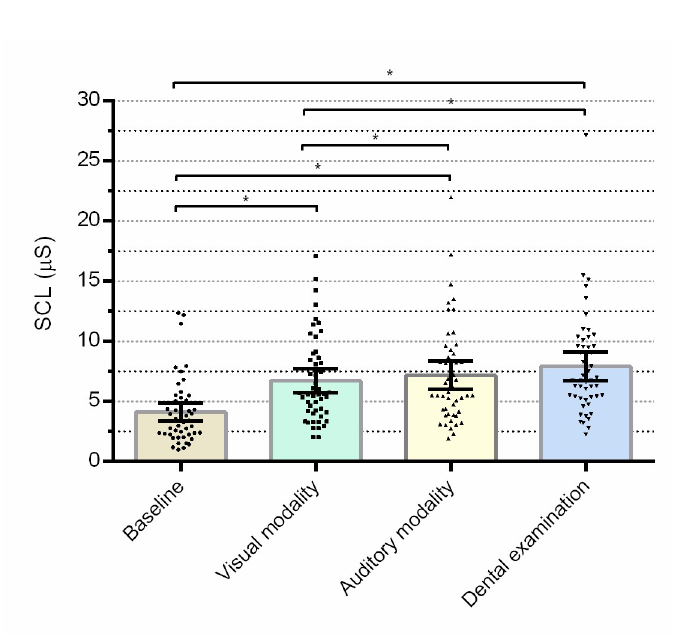
PLOS ONE | https://doi.org/10.1371/journal.pone.0252128 June 3,